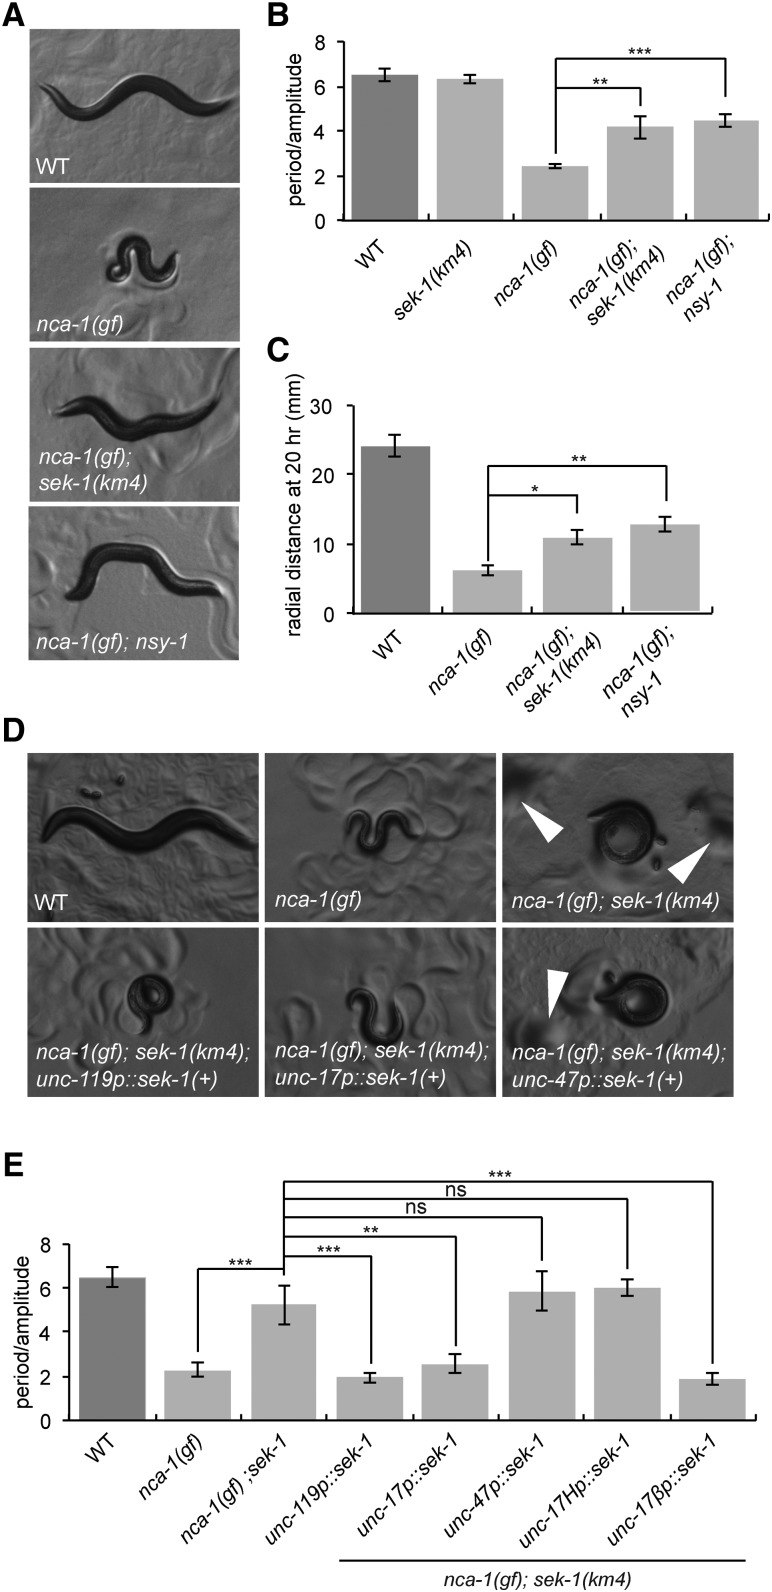
sek-1 and nsy-1 weakly suppress nca-1(gf). (A) nca-1(gf) mutants are small, loopy, and uncoordinated. The phenotypes of nca-1(ox352) animals are partially suppressed by sek-1(km4) and nsy-1(ok593). Photographs of first-day adults. All photos were taken at 60× magnification. (B) sek-1(km4) and nsy-1(ok593) suppress the loopy waveform of nca-1(gf). Error bars = SEM, n = 5. ** P < 0.01, *** P < 0.001. (C) sek-1 and nsy-1 suppress nca-1(gf) locomotion. nca-1(gf) animals travel a small distance from the center of the plate in the radial locomotion assay. nca-1(gf) nsy-1(ok593) and nca-1(gf) sek-1(km4) worms move further than nca-1(gf) worms. Error bars = SEM, n = 30. * P < 0.05, ** P < 0.01. (D) sek-1 acts in acetylcholine neurons to modulate the size and loopy waveform of nca-1(gf). nca-1(ox352) sek-1(km4) animals expressing sek-1 in all neurons [unc-119p::sek-1(+)] or in acetylcholine neurons [unc-17p::sek-1(+)] are loopy and small like nca-1(gf) animals, but nca-1(ox352) sek-1(km4) animals expressing sek-1 in GABA neurons [unc-47p::sek-1(+)] resemble nca-1(gf) sek-1 animals. White arrowheads depict food piles created by nca-1(gf) sek-1(km4) animals due to their uncoordinated locomotion. Such food piles are not made by nca-1(gf) animals. (E) sek-1 acts in acetylcholine motorneurons to modulate the loopy waveform of nca-1(gf). nca-1(ox352) sek-1(km4) worms expressing sek-1 in all neurons [unc-119p::sek-1(+)], acetylcholine neurons [unc-17p::sek-1(+)], or acetylcholine motorneurons [unc-17βp::sek-1(+)] are loopy like nca-1(gf), but nca-1(ox352) sek-1(km4) worms expressing sek-1 in GABA neurons [unc-47p::sek-1(+)] or head acetylcholine neurons [unc-17Hp::sek-1(+)] are similar to nca-1(gf) sek-1. Error bars = SEM, n = 5. ** P < 0.01, *** P < 0.001; ns, P > 0.05. WT, wild type.